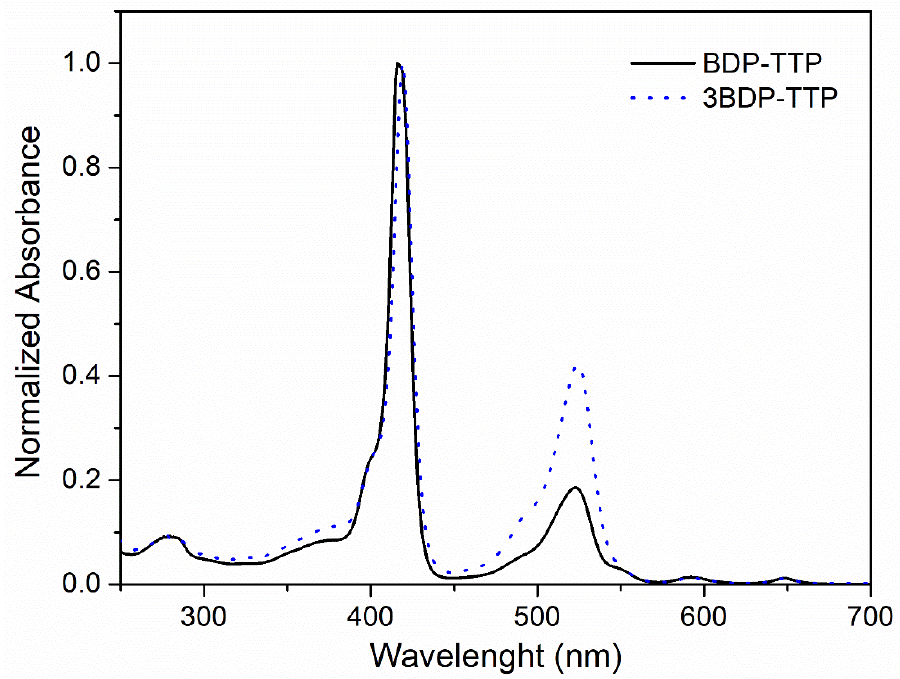
Figure 1. Steady-state absorption spectra of BDP-TTP and 3BDP-TTP compounds in THF (2 × 10 − 6 Figure 1. Steady – state absorption spectra of BDP – TTP and 3BDP – TTP compounds in THF (2 × 10 – 6 M).